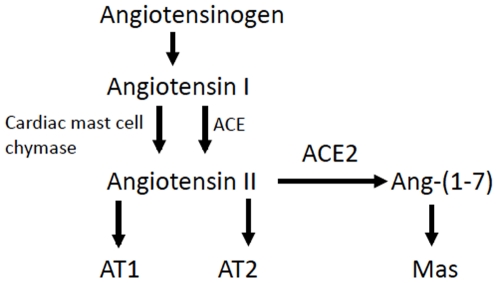
The ACE2 pathway.